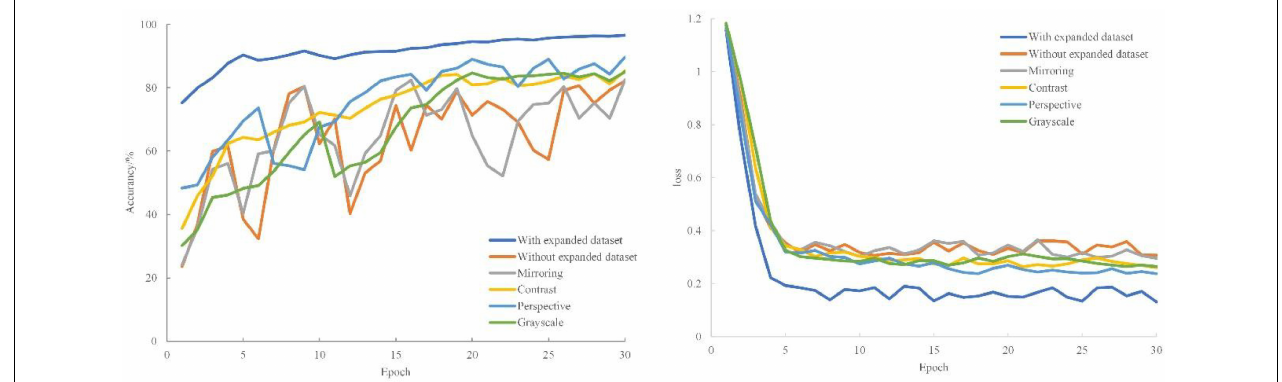
FIGURE 7 | Comparison experiments of different data enhancement effects.